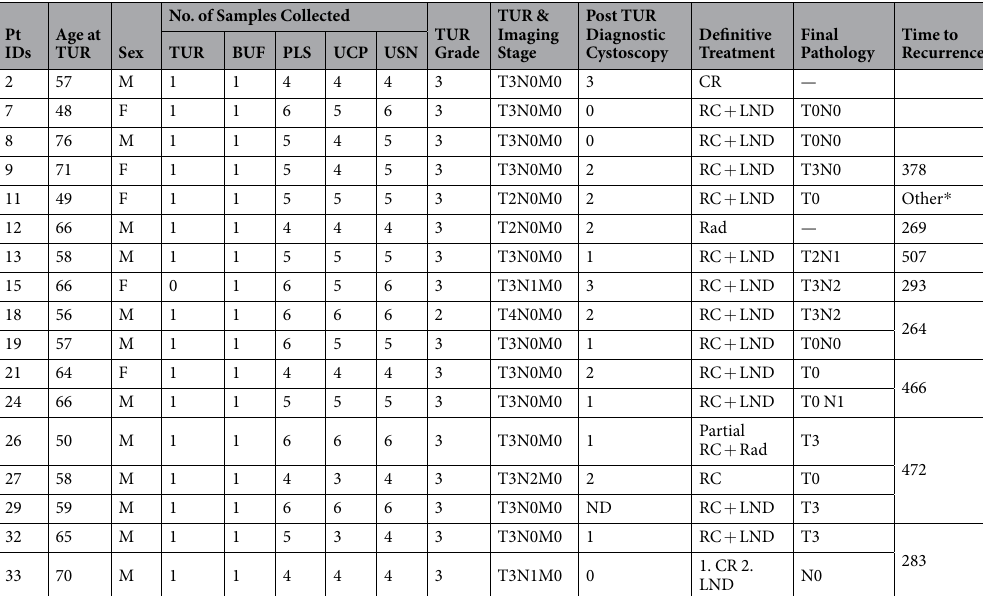
No. of Samples Collected